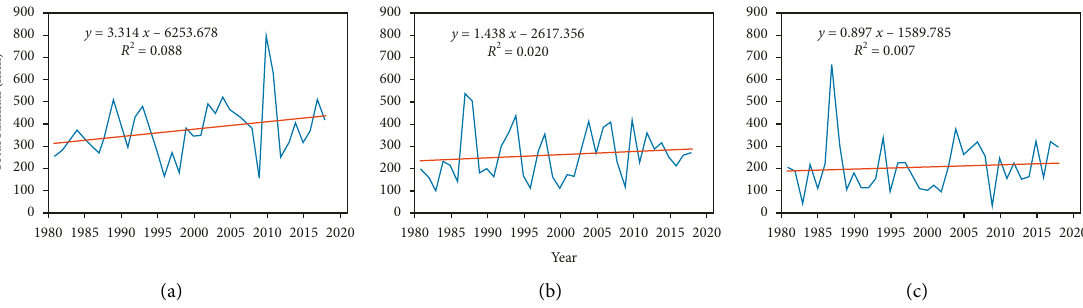
Figure 3: Linear plots of minor seasonal total rainfall amount over stations on the West Coast of Ghana: (a) Axim, (b) Takoradi, and (c) Saltpond. Data used: in situ rainfall data from the Ghana Meteorological